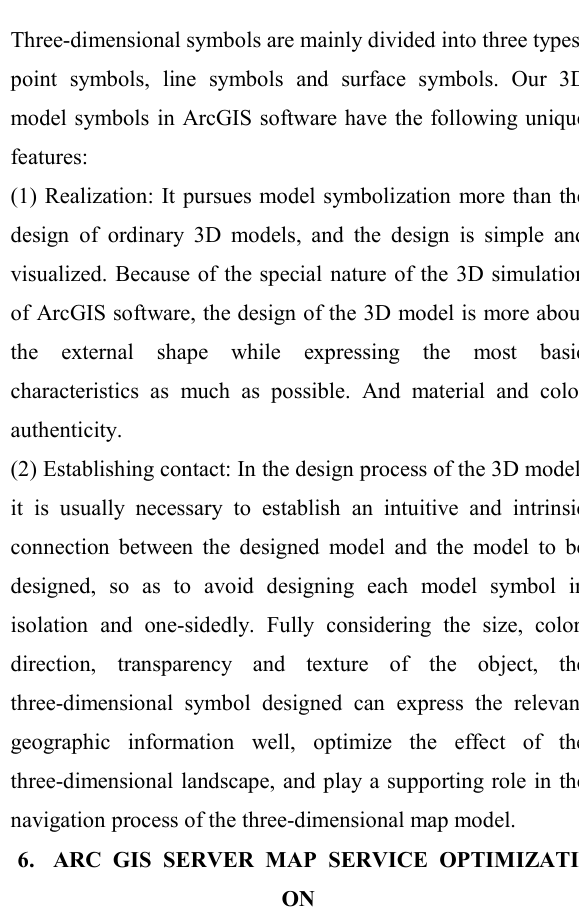
5. DESIGN 3D SYMBOL